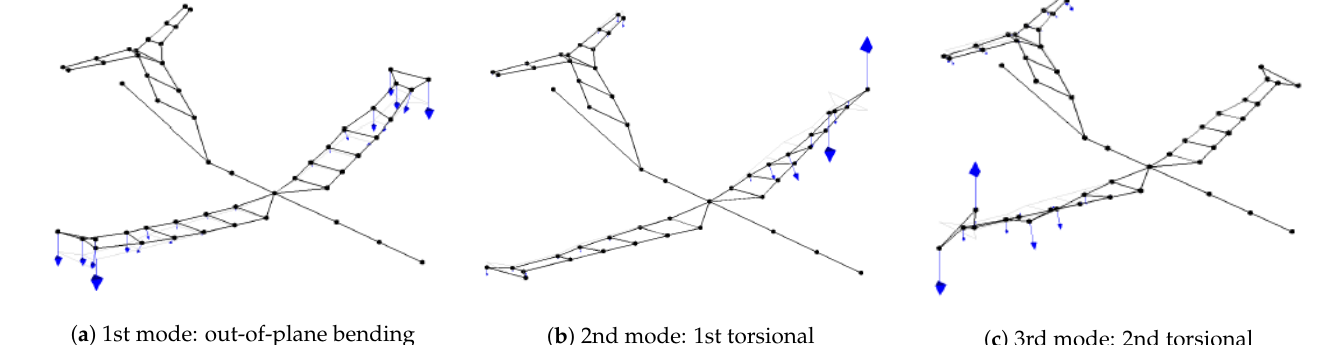
Figure 12. Modal shapes results of the experimental modal